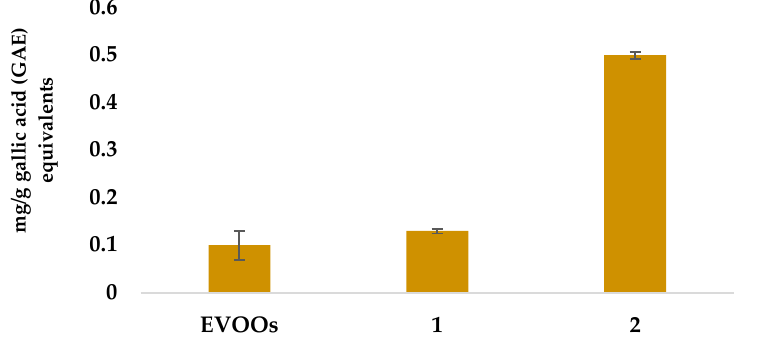
Figure 4. Antiradical activity of Soxhlet oil, 1 and scCO 2 oil, 2 , compared to a mediated result obtained from 45 samples of EVOOs. Results are reported as GAE mg/g oil.